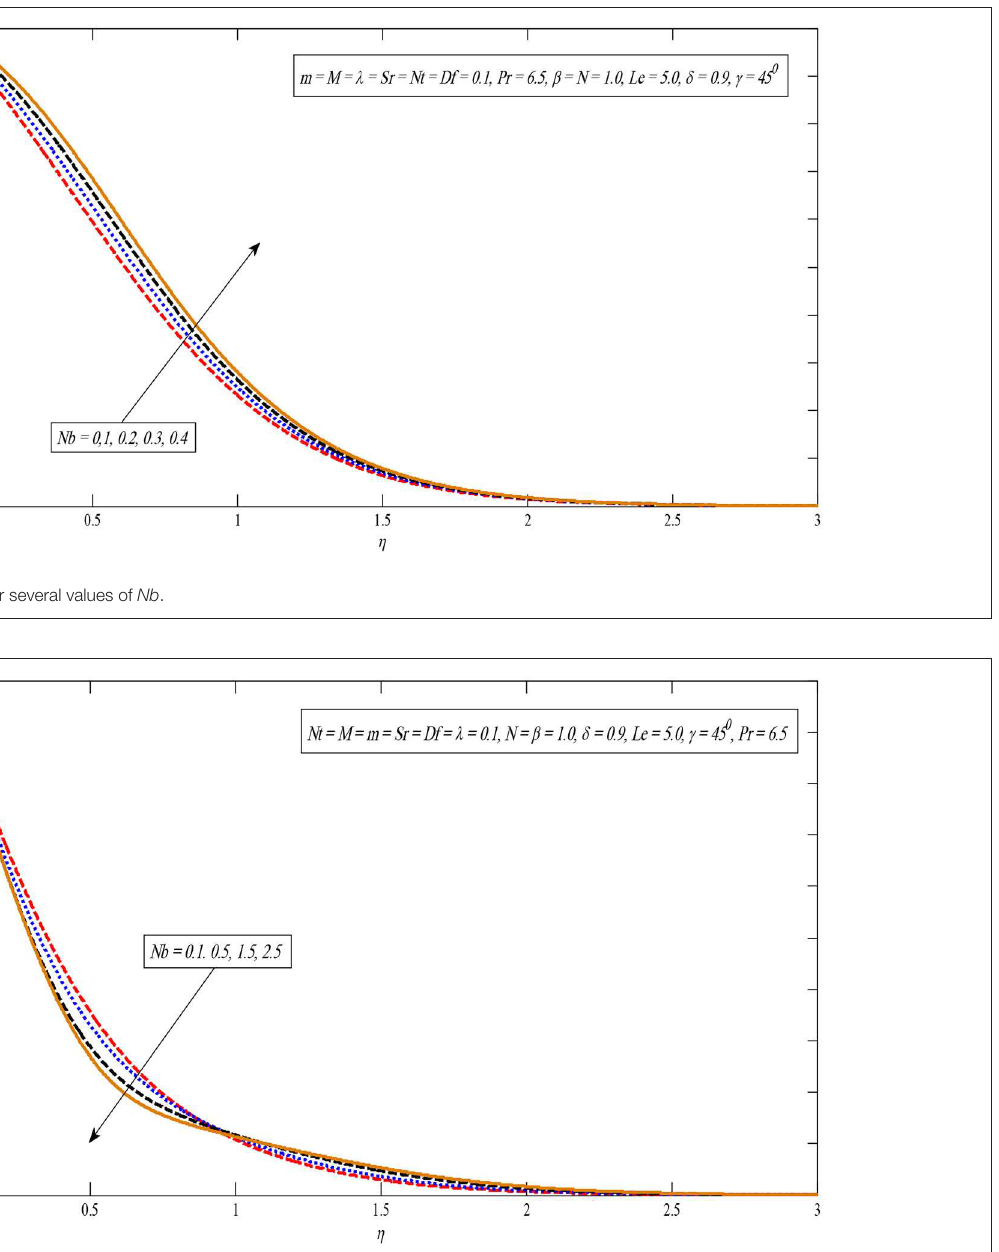
FIGURE 9 | Concentration profile for several values of Nb